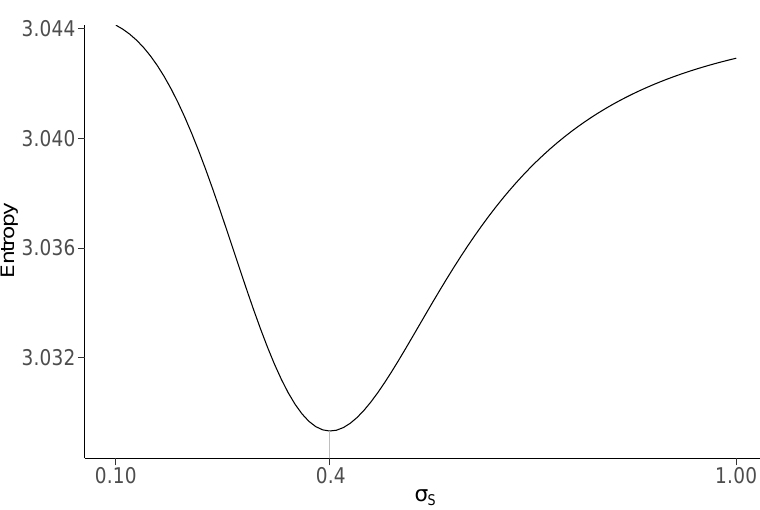
Figure 2. Plot of the entropy as σ S changes from 0.1 to 1.0 and the selected σ S =